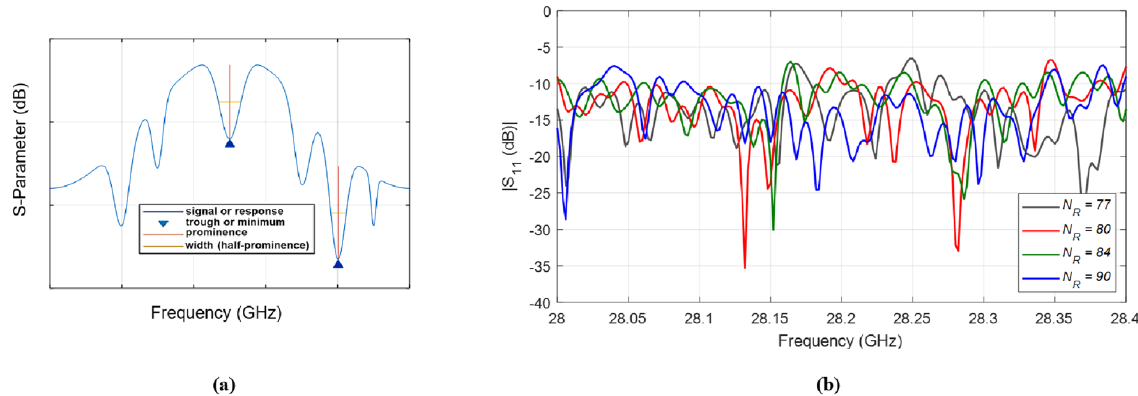
Figure 5. ( a ) Prominence and width of a resonance for a given frequency response. ( b ) Comparison between the frequency responses of selected designs generated during the SADEA-I-based